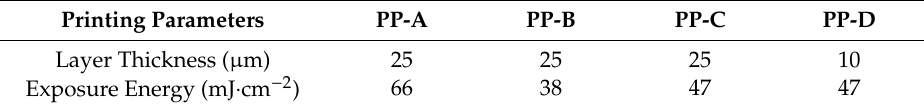
Table 1. Printing parameters (PP) used for shaping AlN three-dimensional structures Printing Parameters